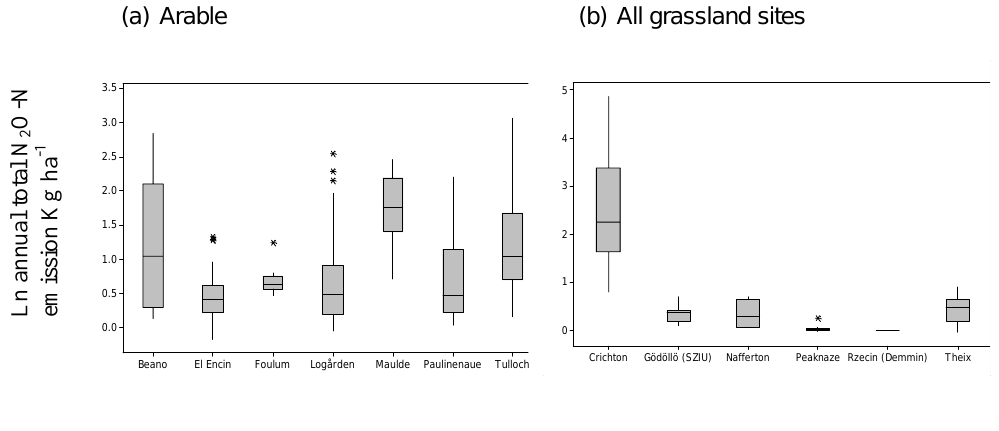
(c) The grassland site at Crichton. Treatments represent different fields. F = fertilised, NF = not fertilised.